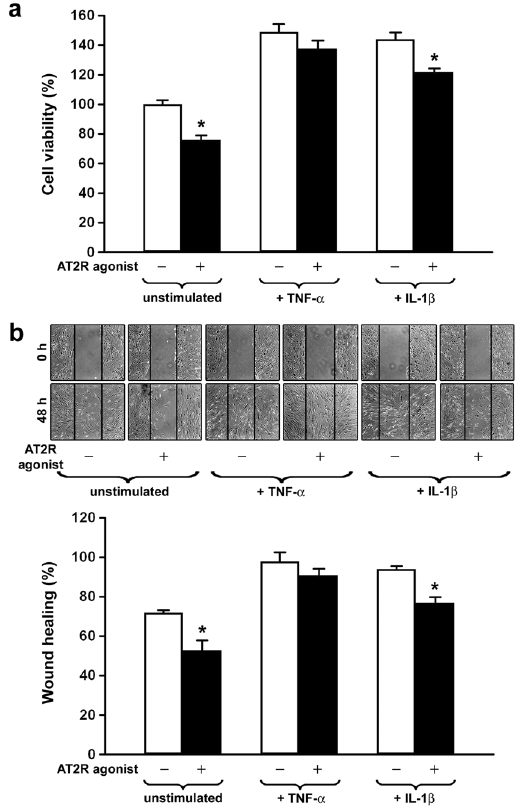
Figure 6. The angiotensin II type 2 receptor (AT2R) agonist CGP42112A decreases proliferation and migration of rheumatoid arthritis fibroblast-like synoviocytes (RA-FLS). ( a ) Cell viability evaluated at basal condition or after treatment with the pro-inflammatory cytokines tumor necrosis factor (TNF)- α and interleukin (IL)-1 β in the presence/absence of AT2R agonist. Cell viability is expressed as the percentage increase/decrease over basal response ( i . e . unstimulated cells without AT2R agonist). Bars represent the mean ± SEM. Results are representative of three independent experiments performed with each one of the six RA-FLS lines. Statistical analysis was carried out with Student’s t test; * p < 0.05 versus the respective condition without AT2R agonist. ( b ) Wound healing capacity of RA-FLS assayed at basal condition or after treatment with TNF- α and IL-1 β in the presence/absence of AT2R agonist. A representative image of the wounded area at 0 hours and 48 hours after scratching is shown for each experimental condition (original magnification × 10). Histograms represent results of quantitative analysis of the percentage of wound repair. Data are mean ± SEM of three independent experiments performed with each one of the six RA-FLS lines. Statistical analysis was carried out with Student’s t test; * p < 0.05 versus the respective condition without AT2R